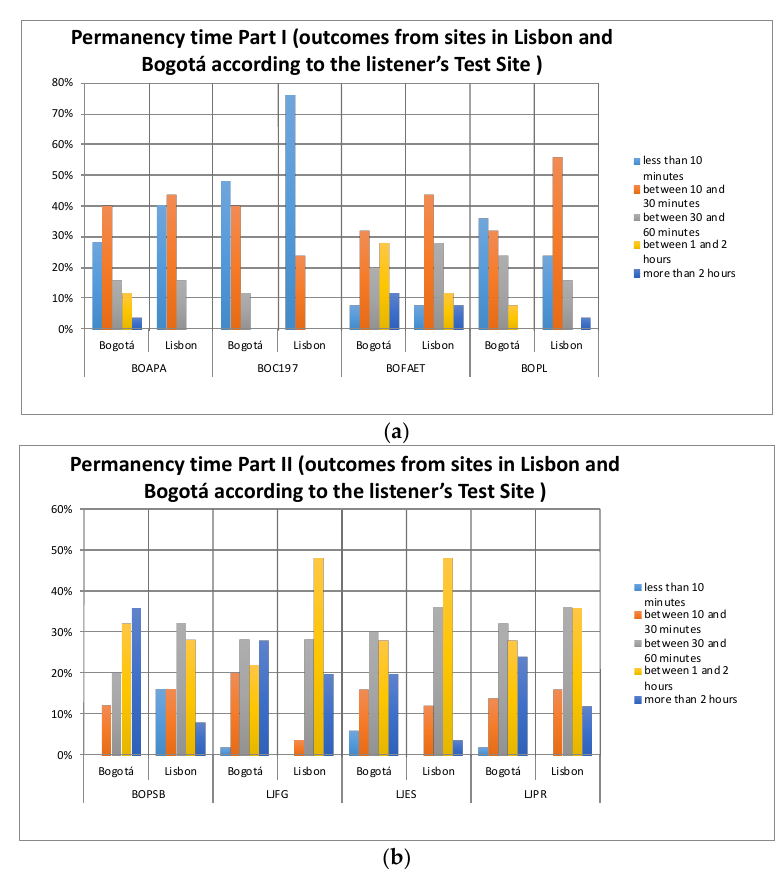
Figure 6. ( a ) Outcomes: permanency time of the listener according to test sites in Lisbon and Bogotá places (Part I); ( b ) Outcomes: permanency time of the listener according to test sites in Lisbon and Bogotá places (Part II). Table 3. X 2 and the likelihood-ratio tests with a α = 0.05 for the eight soundscapes for both the evaluators from Bogot á and from Lisbon. Green values represent statistically significant association between the outcomes and the listener